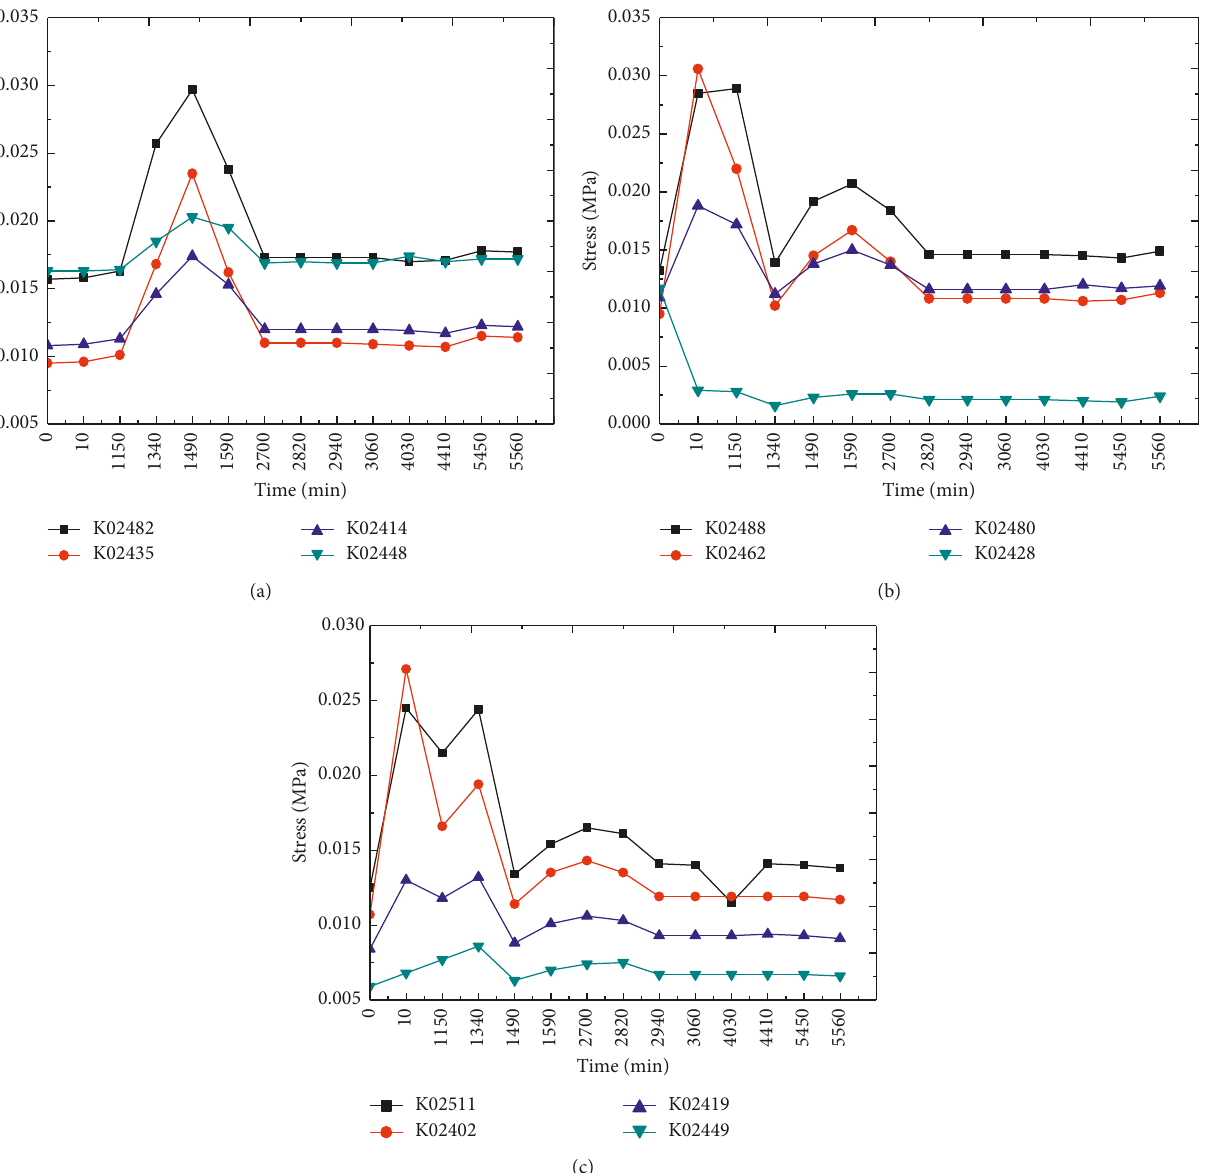
Figure 11: Pore pressure of fly ash area before and after dynamic